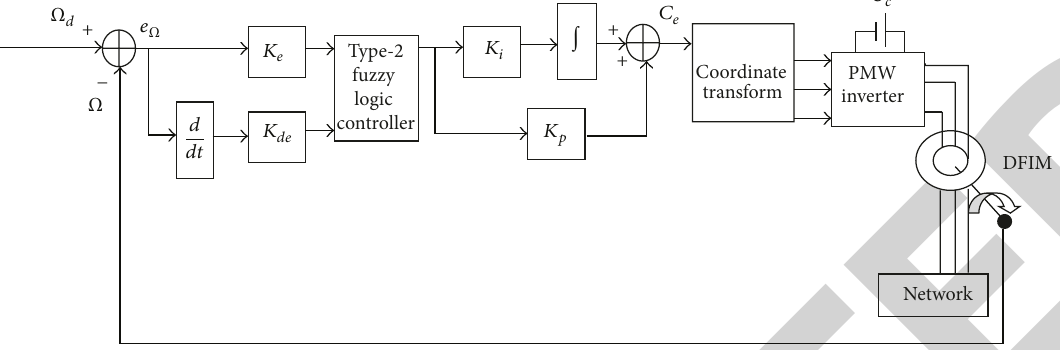
Figure 4: Control scheme for DFIM using the IT2FLC.